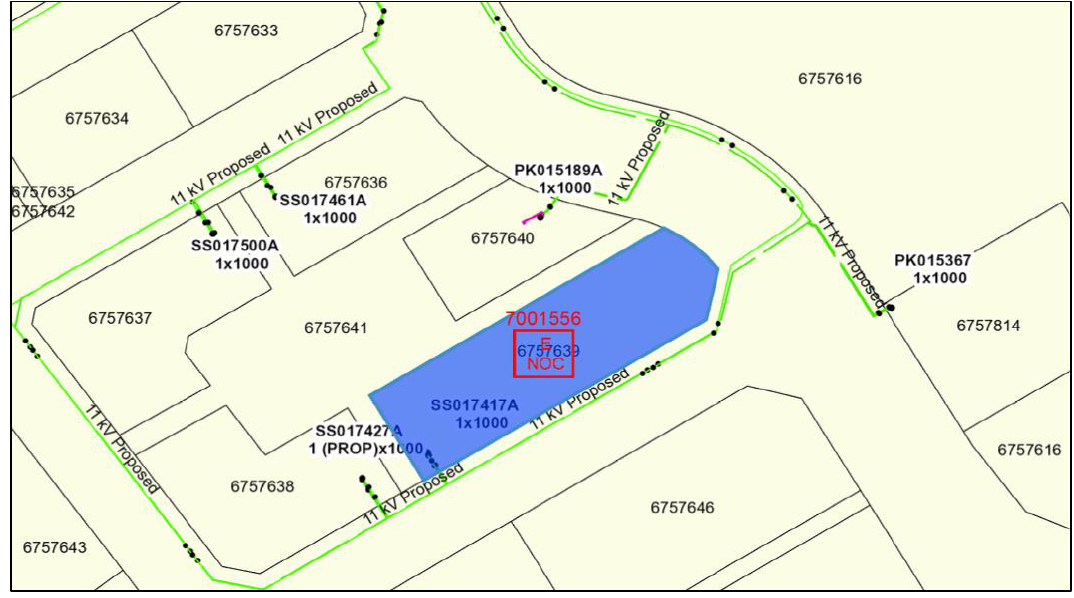
Figure 3. Building Study